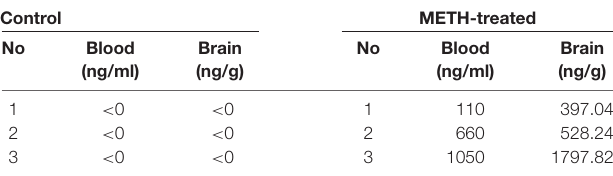
TABLE 1 | Methamphetamine (METH) concentrations in the blood and brain of vehicle-treated and METH-exposed mice at 2 h after the last injection.